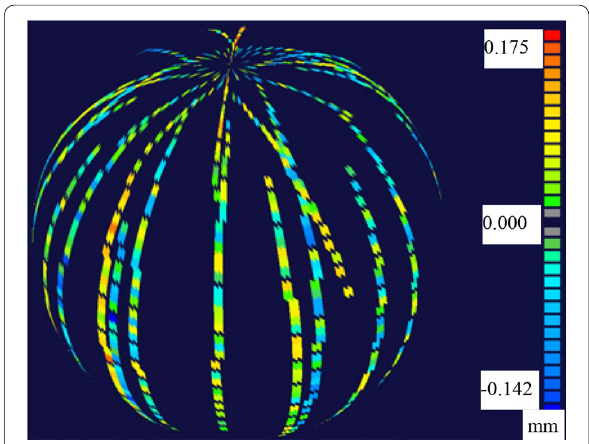
Figure 7 Error of the sphere fitted using the 3D data points transformed by the calibration result after searching optimization